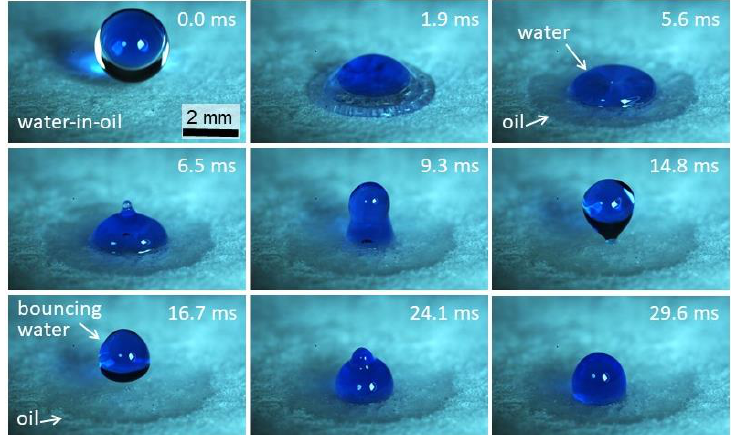
Figure 10. High-speed image sequence of a compound water-in-oil (i.e. , dodecane) drop impacting on CNF foams. Impact conditions: drop diameter D = 2.65 mm, impact velocity V = 1.01 m/s, and water-to-oil ratio α = 0.3. Water is blue-stained to improve contrast. Corresponding time for each frame is indicated.